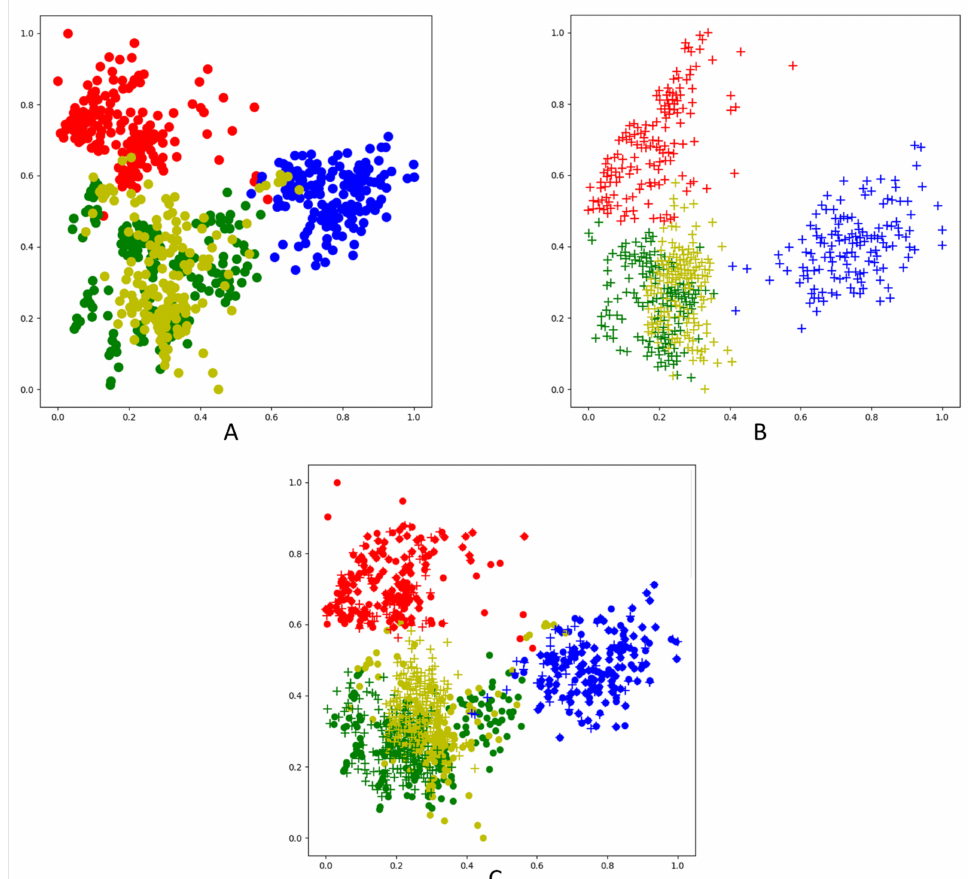
Figure 6. Scatter plot of T-SNE after dimensionality reduction: the circles are the real dataset; the crosses are the fake dataset. Red = melanose; dark-green = healthy; light green = nutritional deficiency; blue = canker. ( A ) only real dataset; ( B ) only fake dataset; ( C ) combination of real and fake